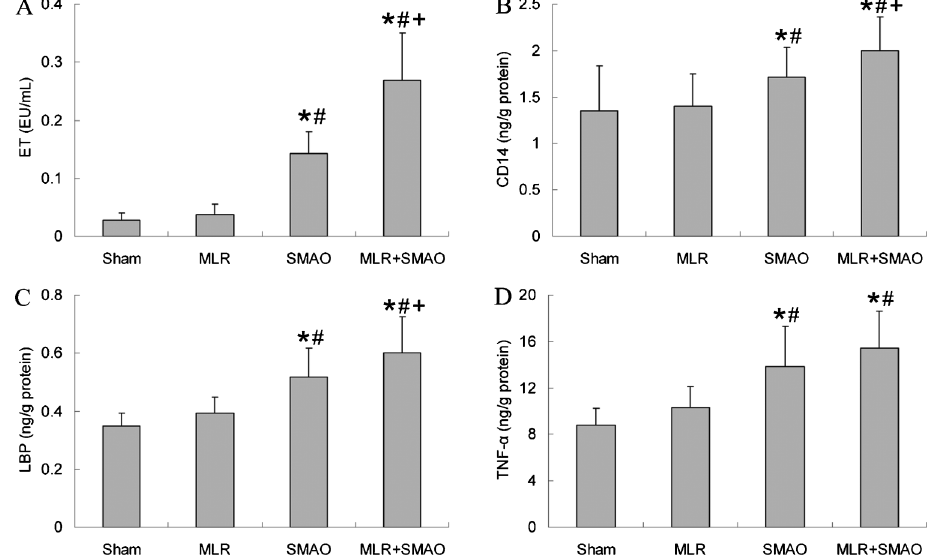
Figure 6. Effect of mesenteric lymph reperfusion (MLR) on the indices related to endotoxin (ET) translocation and inflammatory response in splenic homogenate of rats with superior mesenteric artery occlusion (SMAO) shock. Data are reported as means±SD, n=6. A , ET level. B , Lipopolysaccharide receptor (CD14) level. C , Lipopolysaccharide-binding protein (LBP) level. D , Tumor necrosis factor- a (TNF- a ) level. *P , 0.05 vs sham group; # P , 0.05 vs MLR group; + P , 0.05 vs SMAO group (one-way